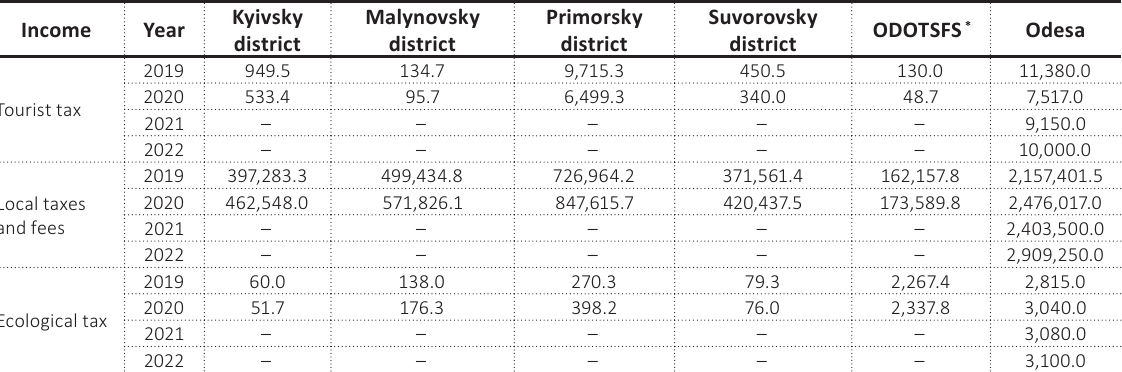
Table A3. Volumes of revenues from tourist tax as part of local taxes and environmental tax as